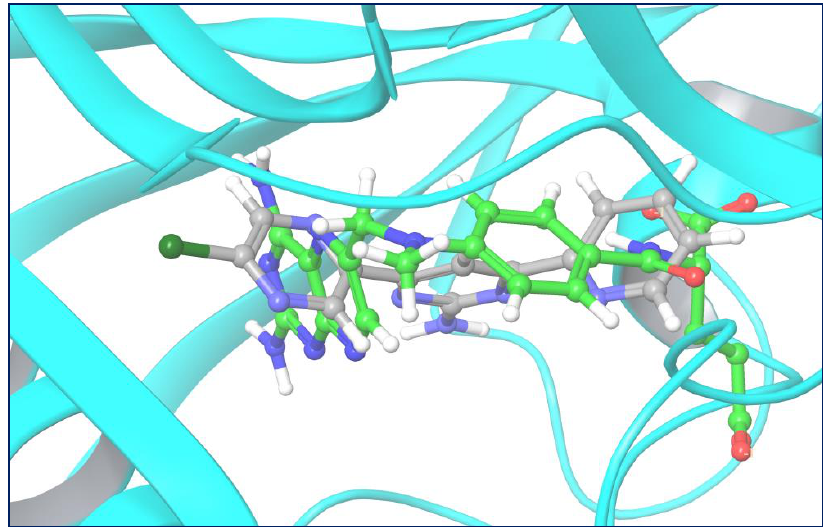
Figure 6. Superimposition of compound 35 (grey) with the co-crystal structure (green) at the active site of the human dihydrofolate reductase receptor (PDB code: 1U72).